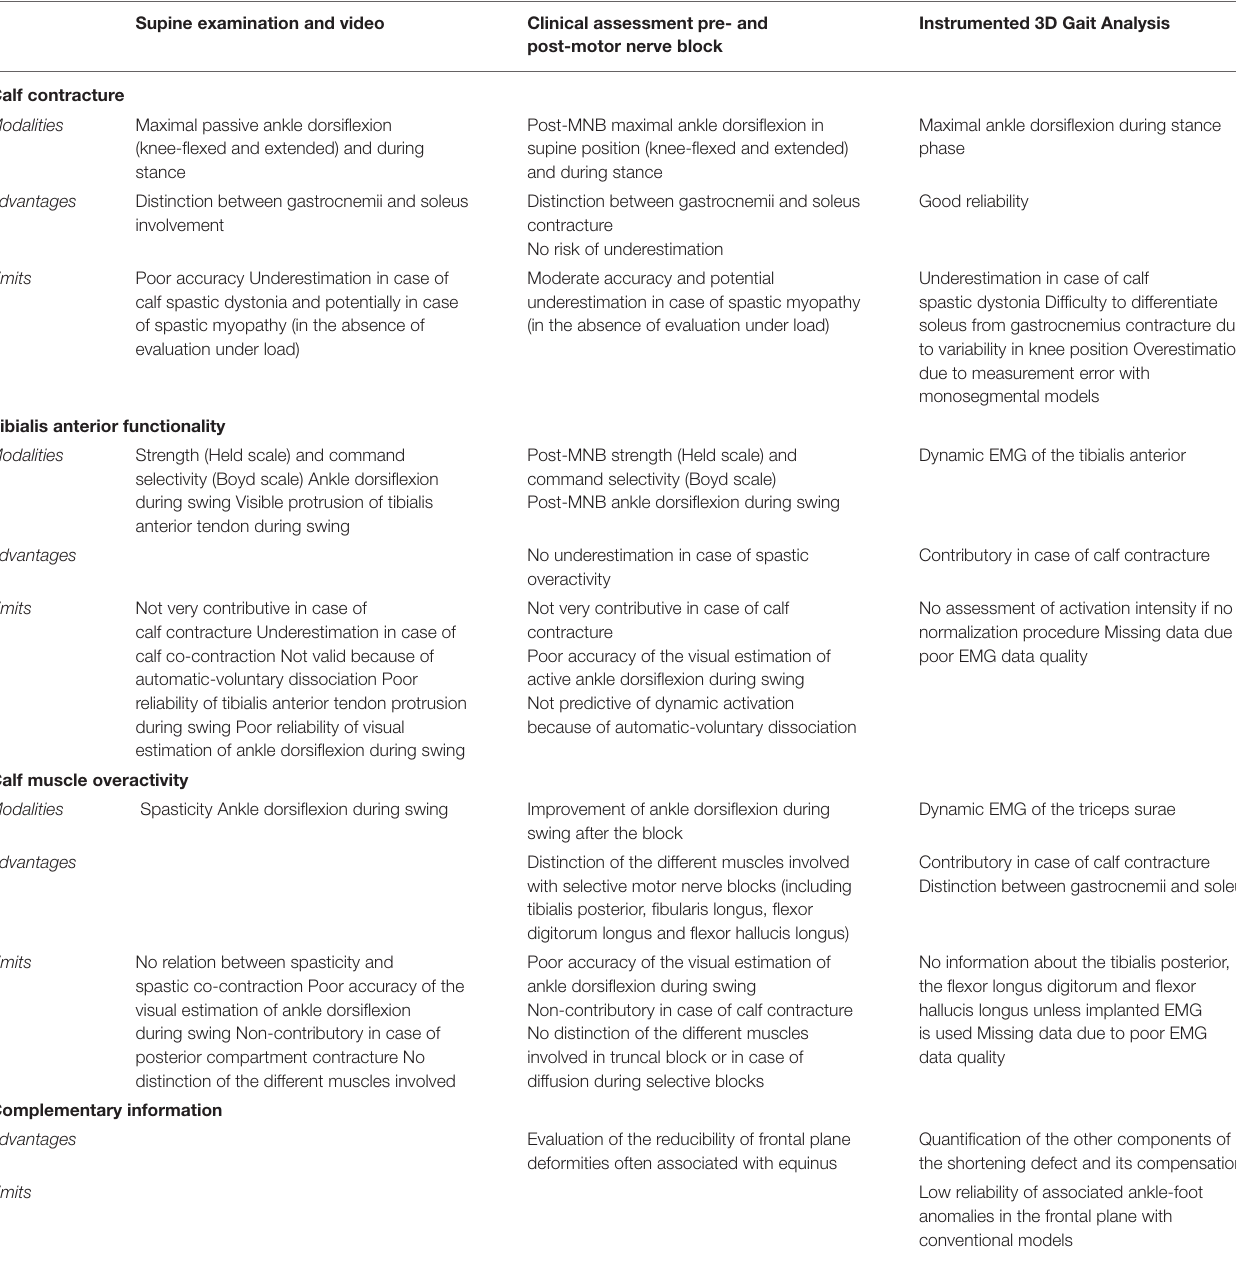
TABLE 4 | Respective advantages and limits of methods used to assess spastic equinus